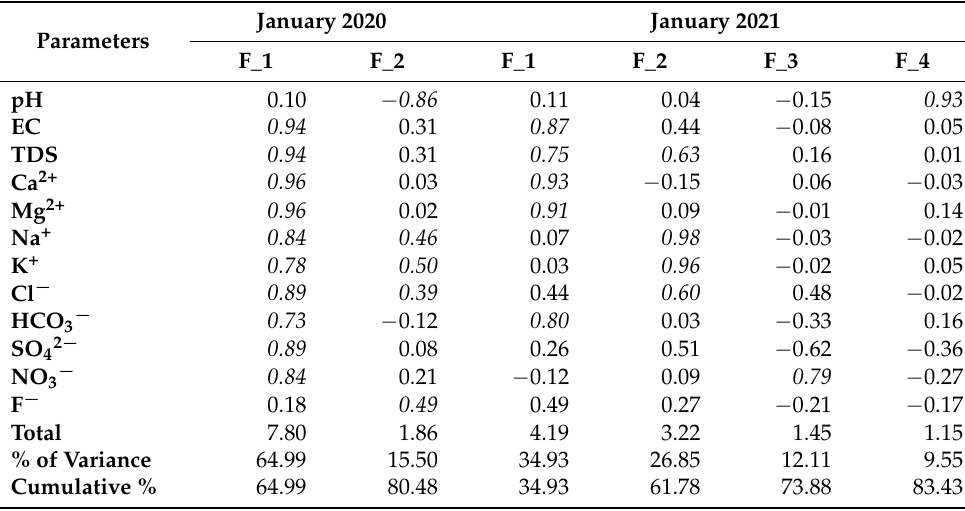
Table 5. Principal component analysis for the analytical